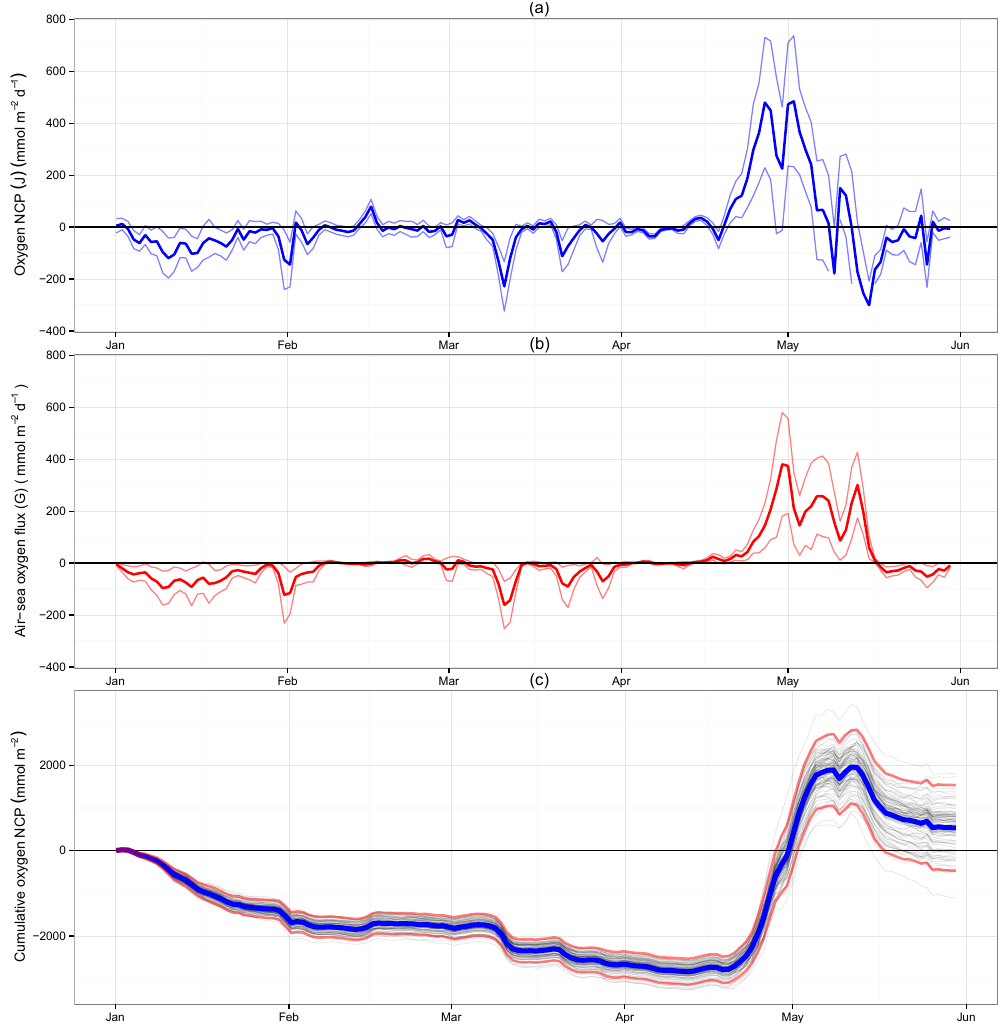
Figure 4. Spring 2008 Warp Anchorage time series. (a) Net community production ( J ); negative values correspond to net respiration. (b) Oxygen air–sea gas exchange ( G ); negative values correspond to movement into the sea. For (a) and (b) thin lines represent 2 σ confidence bounds. (c) Cumulative net community production, mean value shown in blue, each run shown in grey, 2 σ confidence bounds in red.